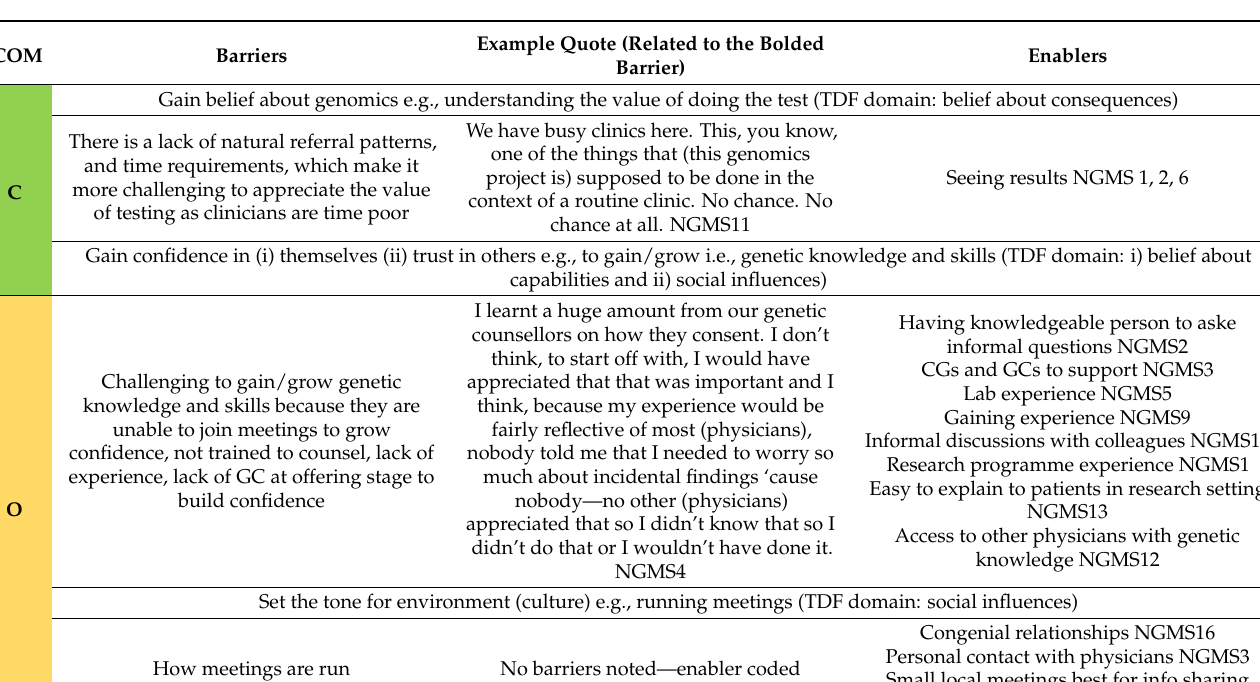
Table 2. Target behaviour area 1 (ensuring appropriate patients receive testing) grouped barriers coded by the Theoretical Domains Framework and Capability, Opportunity and Motivation (COM) Behaviour framework. Detailed information about the barriers and enablers reported for each grouped barrier can be found in the Supplementary Files (Supplementary Table